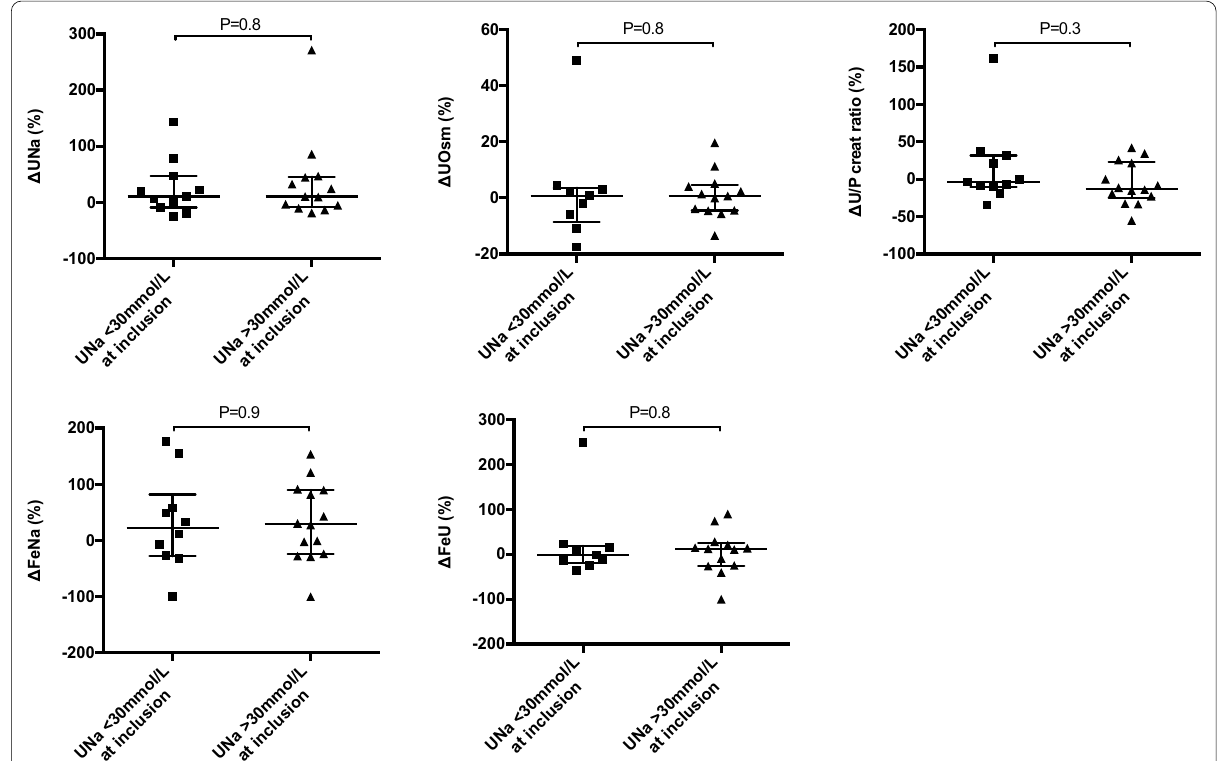
Fig. 5 Urine concentration ability according to the natriuresis at inclusion. Intra‑individual variations of urine sodium (UNa), urine osmolality (UOsm), urine‑to‑plasma creatinine ratio (U/P creat ratio), fractional excretion of sodium (FeNA) and fractional excretion of urea (FeU) from low to high‑MAP target period according to UNa at inclusion, expressed as a